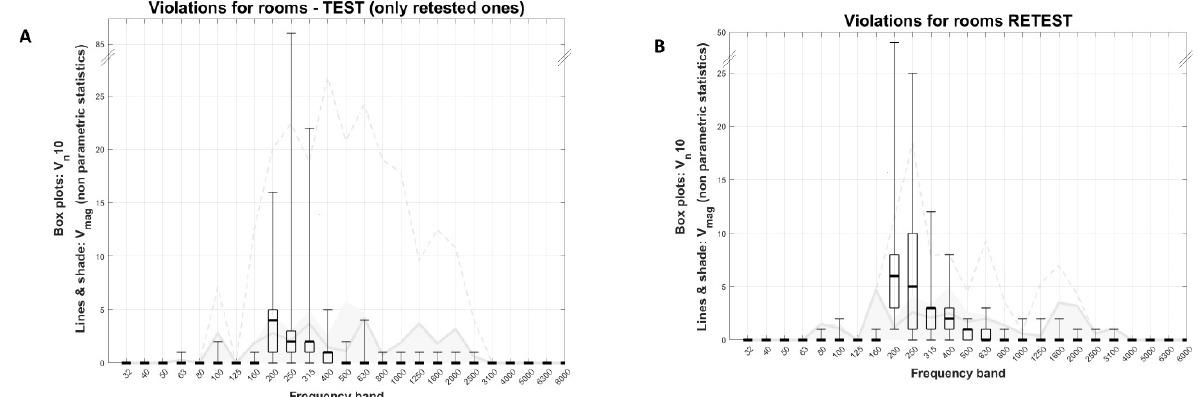
Figure 5. Test ( A ) and retest ( B ) descriptive statistics of V n 10 in boxplots and V mag in lines and shaded areas in 9 rooms (1, 2, 4–7 and 10–12). Solid grey line: median, shaded area: 1st to 3rd quartile, dashed line: max. V n 10 is the number of data points (1 sample per second) that violate Maximum Permissible Ambient noise levels. V mag is the magnitude of the violation in dB.